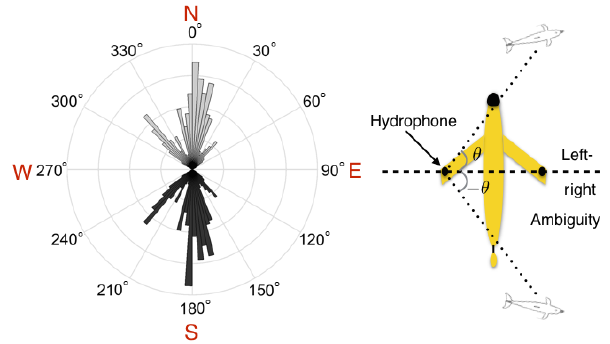
Figure 18. Estimated bearing angles from automatic detections of file 06 shown in polar form. Angles are relative to the axis of the glider, which was heading north (0 ◦ ) during data recording. Be- cause the hydrophones were mounted horizontally, the bearings have front/back ambiguity, shown in the diagram on the